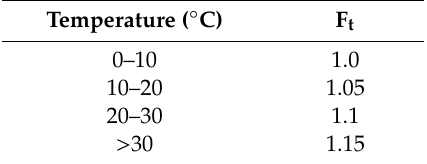
Table 3. Values for the average annual temperature factors (F t